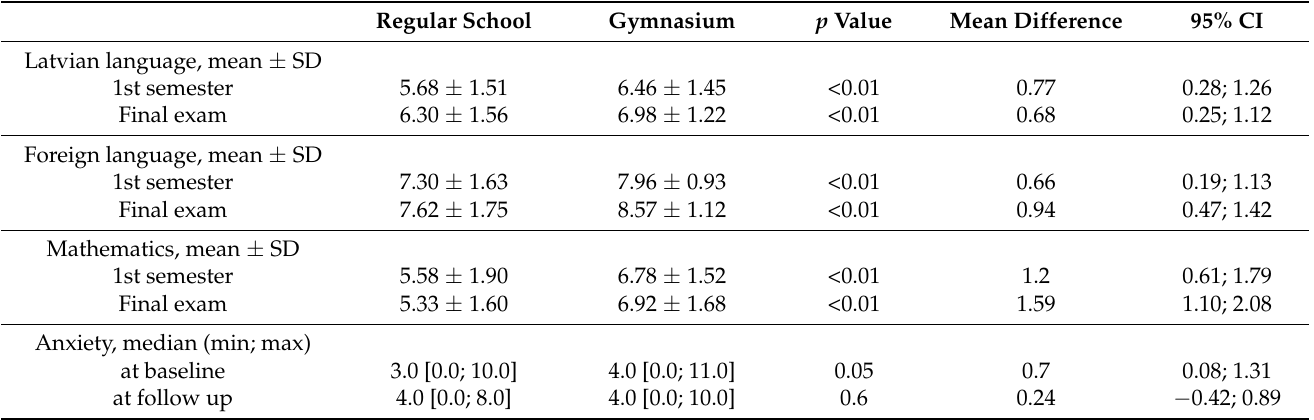
Table 2. Differences in grades, anxiety, and QOL, by